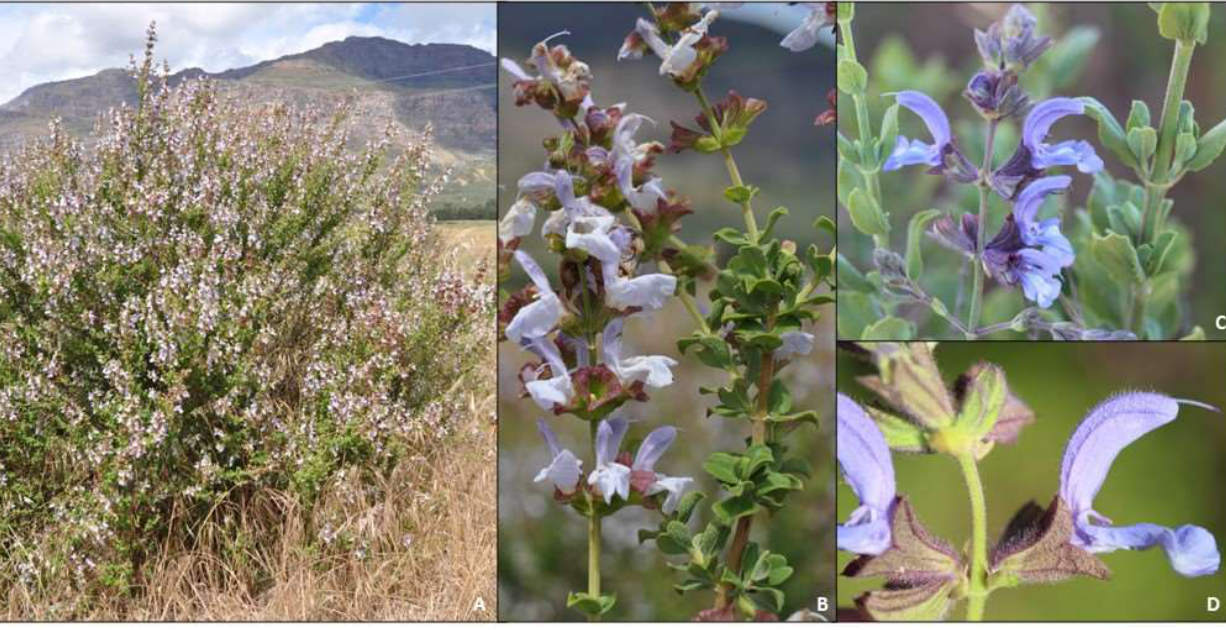
Figure 5. Morphology and diagnostic characters of Salvia chamelaeagnea . ( A ) habit (Piketberg); ( B ) inflorescence and leaves (Piketberg); ( C ) leaves and flowers (Darling); ( D ) flower (note glandular calyx). All photographs taken by B.-E. Van Wyk.